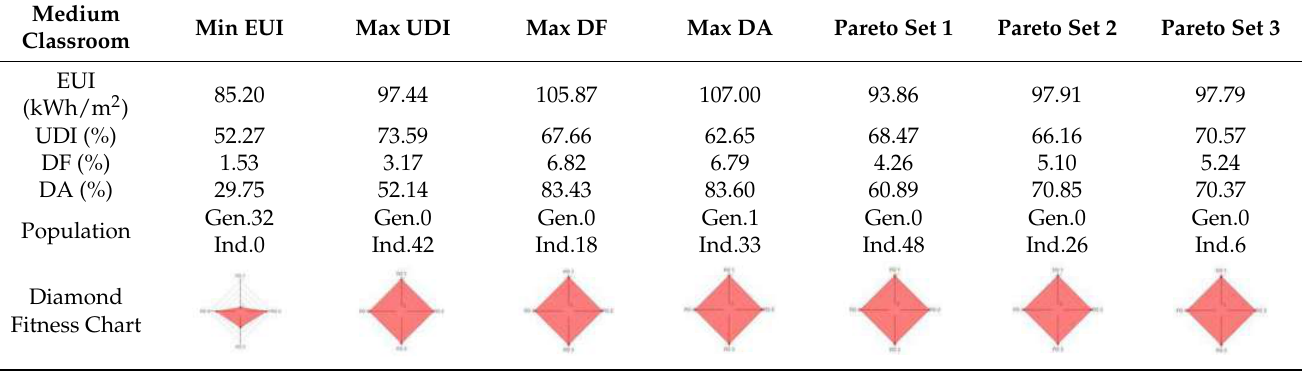
Table 11. The case of medium-sized classrooms with window openings on the west facade.